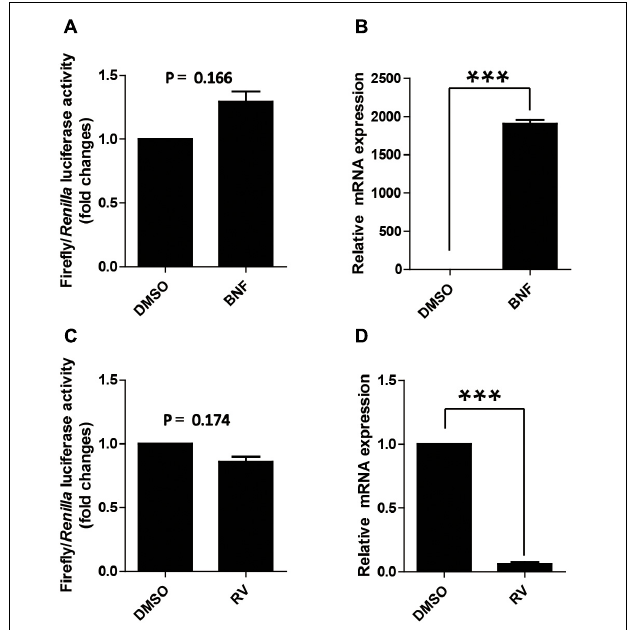
FIGURE 3 | Effect of the agonist and antagonist for AhR to treat cells on promoter activity of p CYP1A1. (A) Effect of β -naphthoflavone on -43-Luc plasmid promoter activity. “BNF” indicates β -naphthoflavone treatment at a concentration of 2 µ M for 24 h. DMSO treated cells were used as the control. The values on the ordinate represent the ratio of the activity of the promoter after BNF treatment to the value of the activity of the DMSO treated promoter. (B) The relative quantified mRNA level of CYP1A1 in LLC-PK1 Cells treated with BNF for 24 h. DMSO-treated cells were used as the control. In the control cells, p CYP1A1 relative to glyceraldehydes-3-phosphate dehydrogenase (GADPH) mRNA level was set to 1. (C) Effect of resveratrol on -43-Luc plasmid promoter activity. “RV” means resveratrol used at a concentration of 180 µ M for 24 h. DMSO-treated cells were used as the control. The values on the ordinate represent the ratio of the activity of the promoter after RV treatment to the value of the activity of the DMSO-treated promoter. (D) The relative quantified mRNA level of CYP1A1 in LLC-PK1 cells treated with 180 µ M RV for 24 h. DMSO-treated cells served as the control. In the control cells, p CYP1A1 relative to the mRNA level of GAPDH was set to 1. The experiment was repeated three times. Error bars represent the standard deviation of three replicates. ∗∗∗ P <